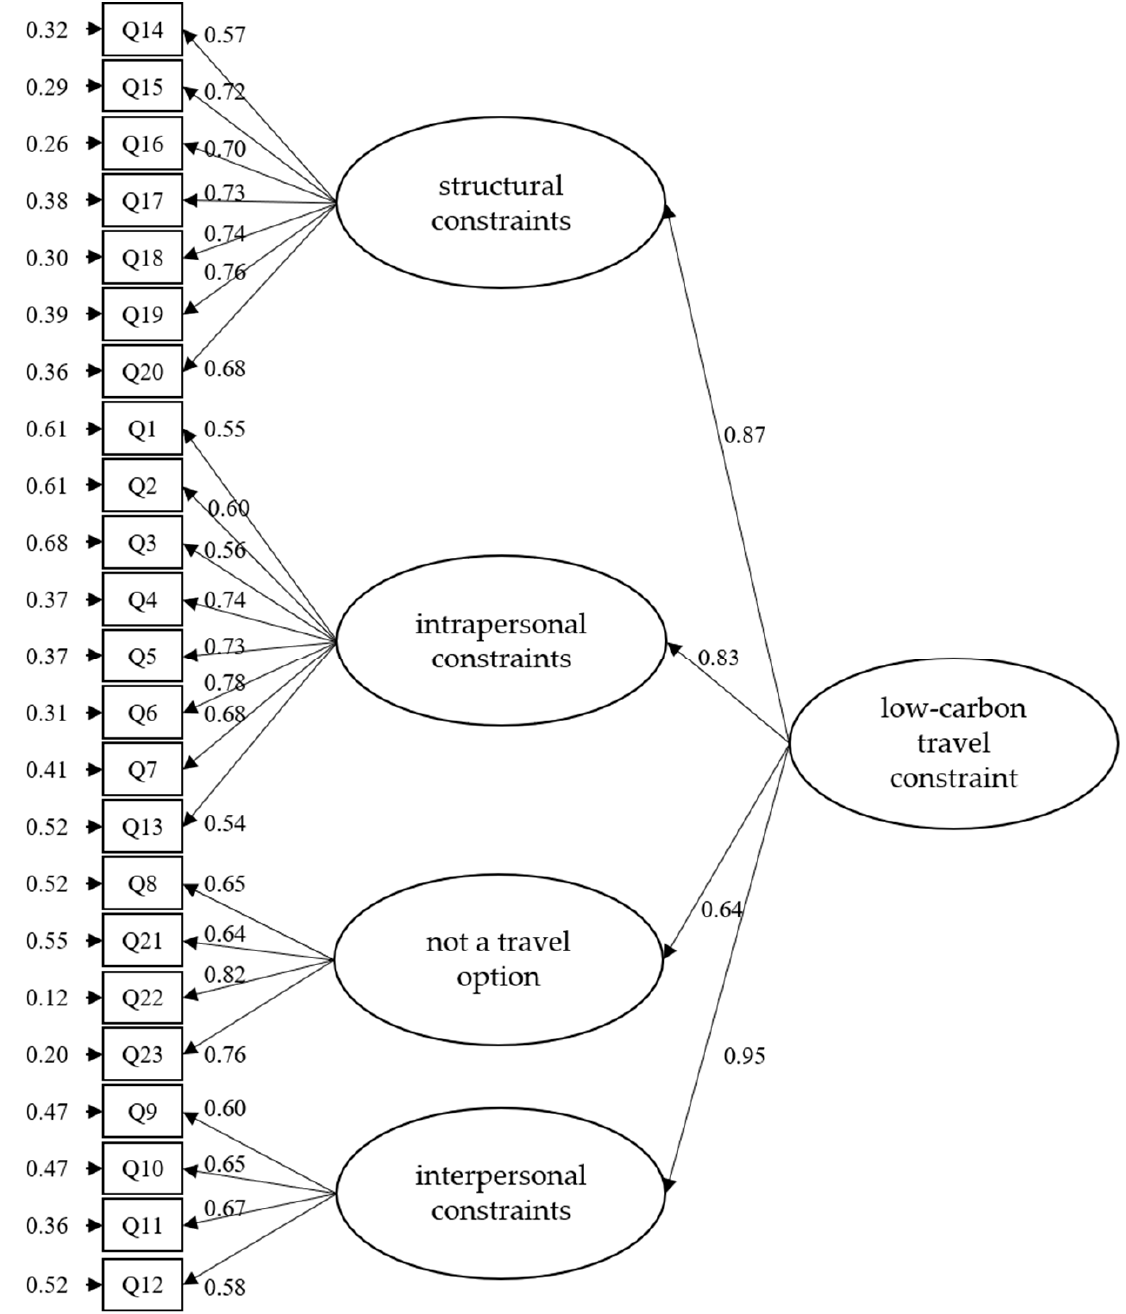
Figure 3. The second-order model of LCTCS.